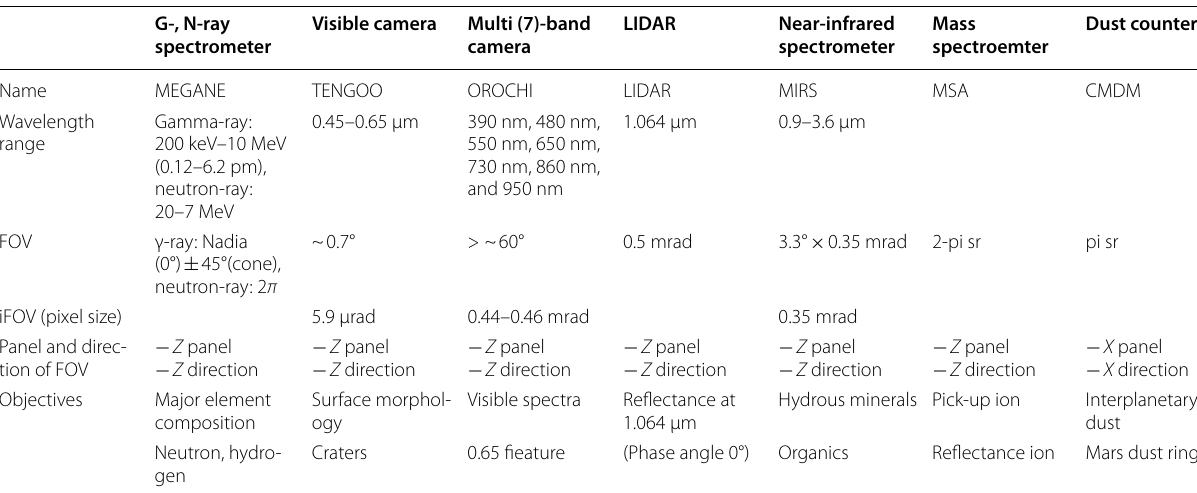
Table 2 MMX remote sensing